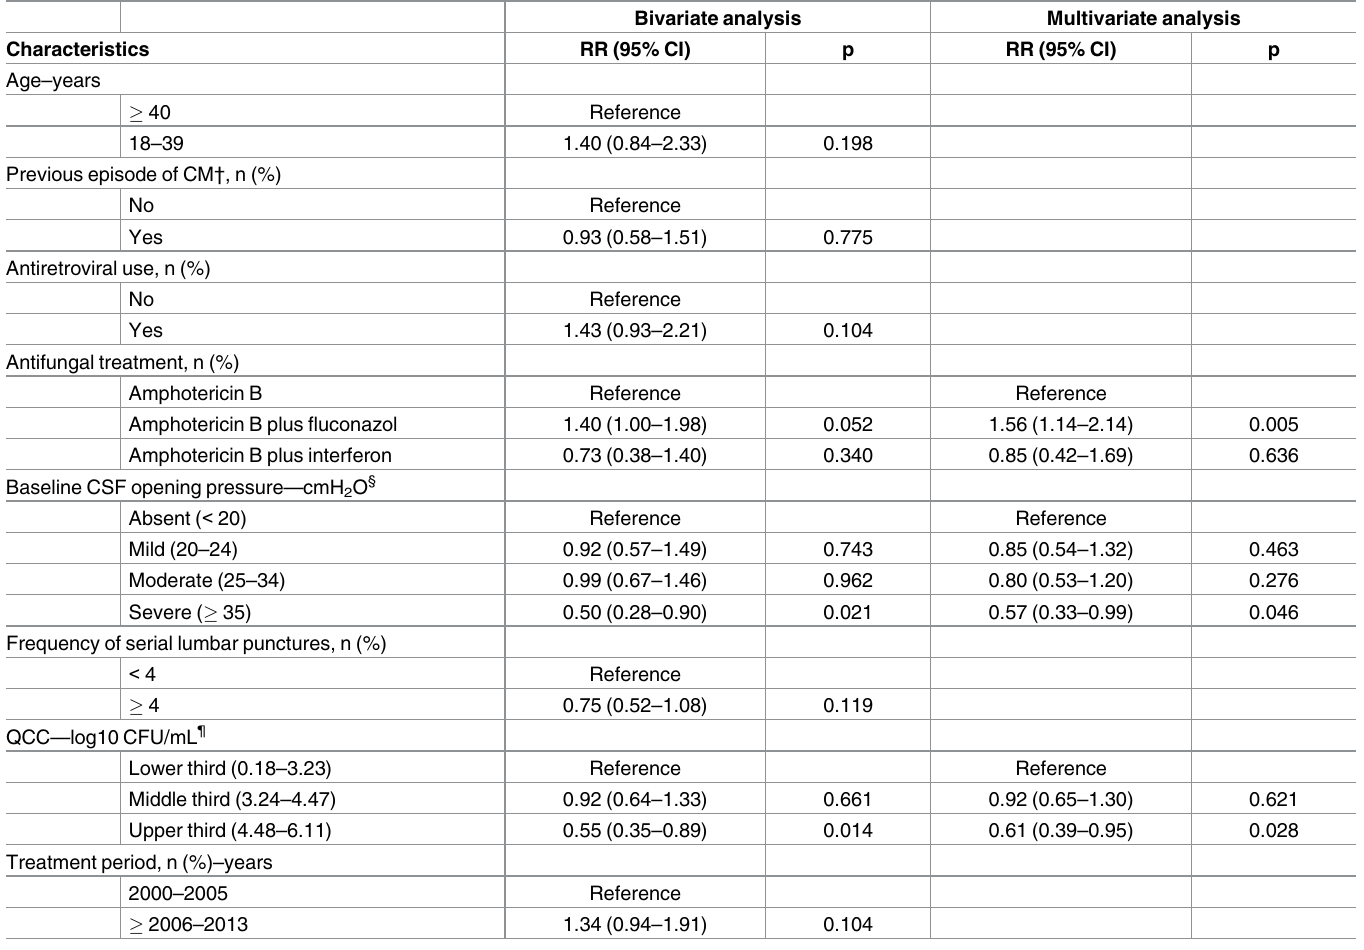
Table 3. Risk factors associated with early mycological clearancein caseswith HIV-associated CM in Peru *